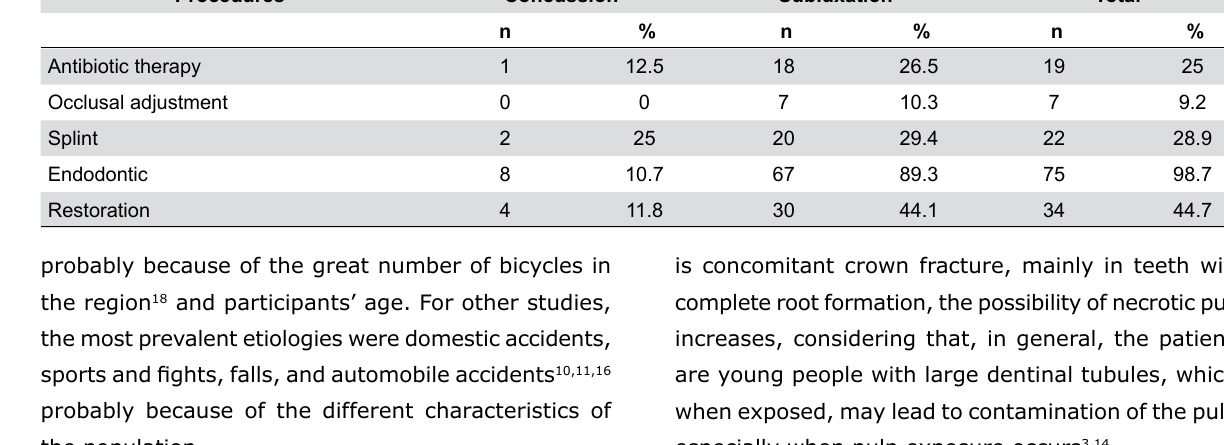
Evaluation of cases of concussion and subluxation in the permanent dentition: a retrospective